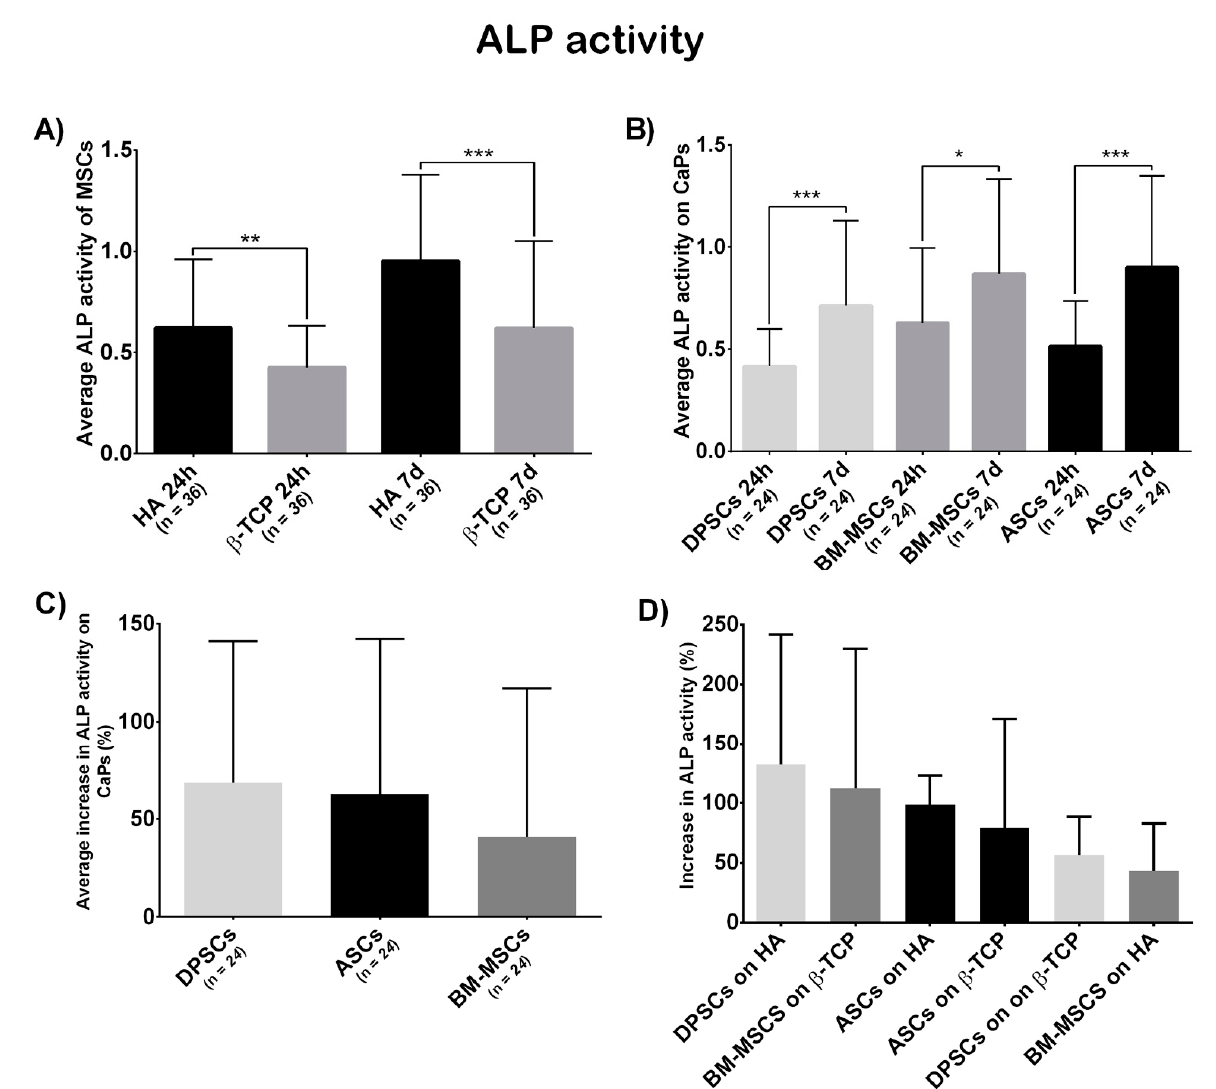
Figure 6. ( A ) Average ALP activity shown by all MSCs on each CaP—Hydroxyapatite (HA) and ß-tricalcium phosphate ( β -TCP); ( B ) everage ALP activity shown by each MSC on both CaPs—Adipose tissue (ASCs), dental pulp (DPSCs), and bone marrow (BM-MSCs); ( C ) the average increase in ALP activity (in percentage) presented by each MSC on both CaPs— Adipose tissue (ASCs), dental pulp (DPSCs), and bone marrow (BM-MSCs); and ( D ) increase in ALP activity (in percentage) presented by each construct—Hydroxyapatite (HA), ß-tricalcium phosphate ( β -TCP), adipose tissue (ASCs), dental pulp (DPSCs), and bone marrow (BM-MSCs). All data are shown as mean ± standard deviation. Significance level: * p ≤ 0.05, ** p ≤ 0.01, *** p ≤